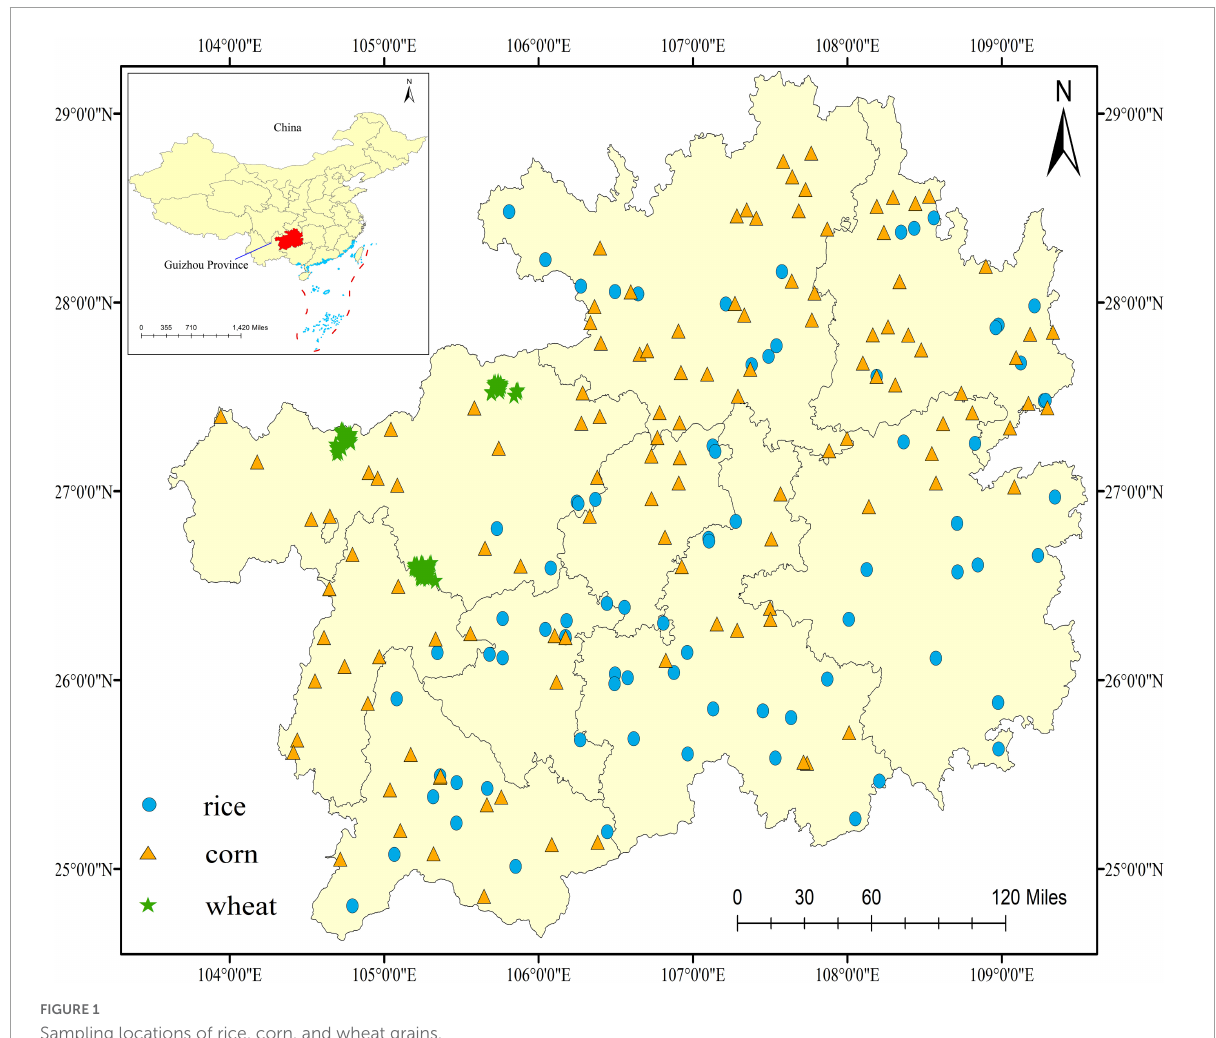
FIGURE1 Sampling locations of rice, corn, and wheat